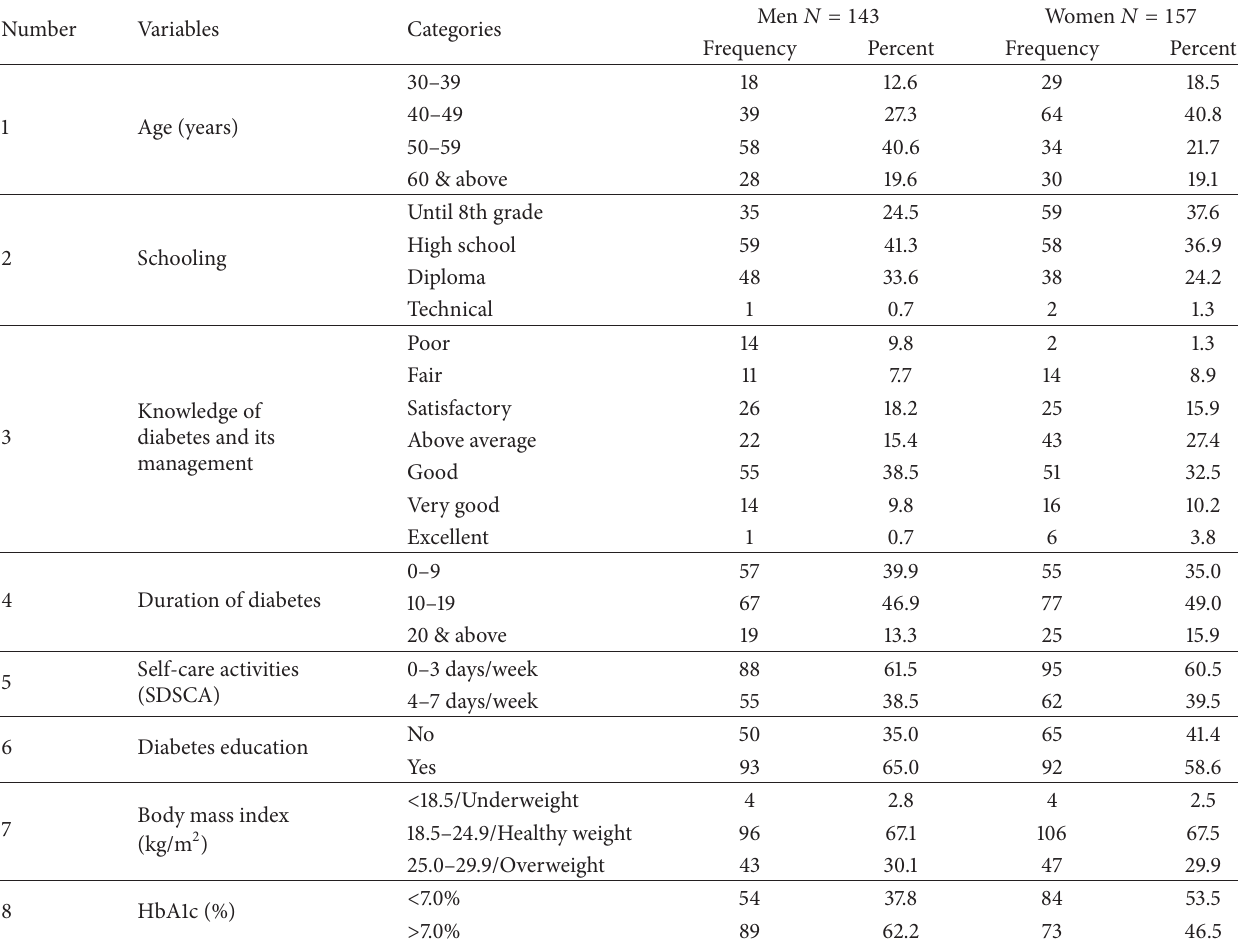
Table 1: Personal and clinical characteristics among Omani men and women ( 𝑁 = 300